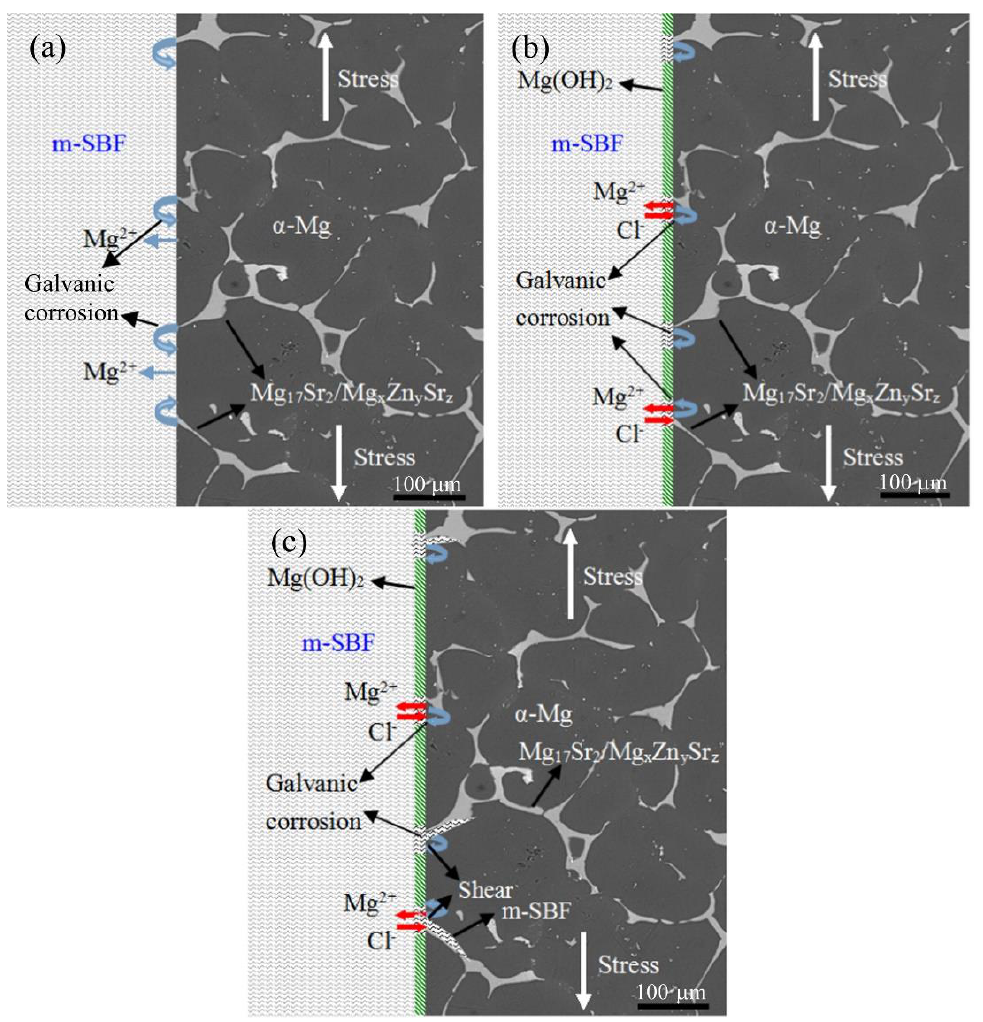
Figure 4. Schematic diagrams for intergranular stress corrosion cracking (IGSCC) propagation in m-SBF: ( a ) Galvanic corrosion of Mg matrix with grain boundaries; ( b ) galvanic corrosion developed through the partially Mg(OH) 2 film; ( c ) accelerated galvanic corrosion along the grain boundaries under stress [107].